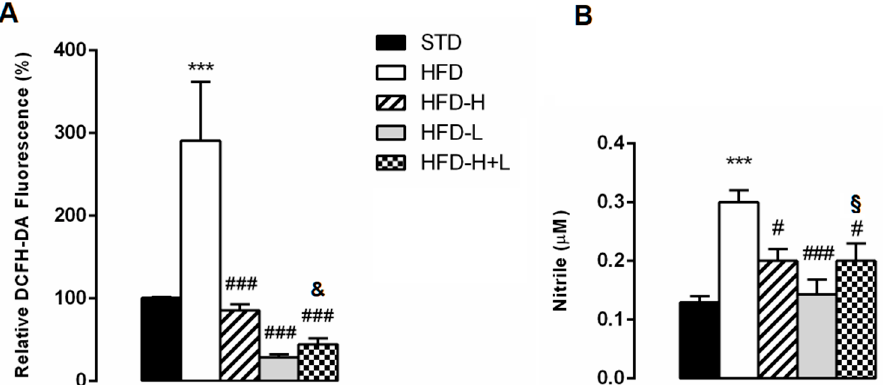
Figure 6. Brain oxidative stress. ( A ) Levels of ROS in the brain of STD, HFD, HFD-H, HFD-L and HFD-H + L mice. ( B ) Nitrite concentration in the brain of STD, HFD, HFD-H, HFD-L and HFD-H + L mice. Data are mean values ± S.E.M. (n = 8/group). *** p < 0.001 vs. STD mice; # p < 0.05, ### p < 0.001 vs. HFD mice; & p < 0.05 vs. HFD-H mice; § p < 0.05 vs. HFD-L mice. Table 1. Gene expression profiles involved in AD in HFD/Lean, HFD-H/HFD, HFD-L/HFD and HFD-H + L/HFD, which were significantly downregulated by